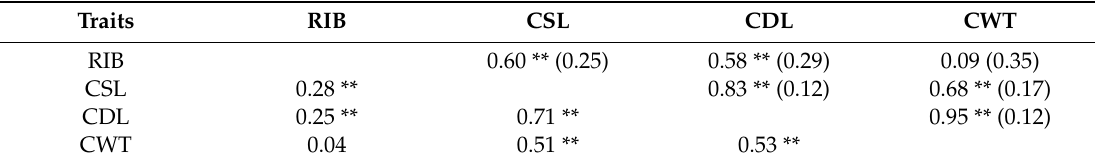
Table 2. Correlation analyses between RIB and carcass traits in Suhuai fattening